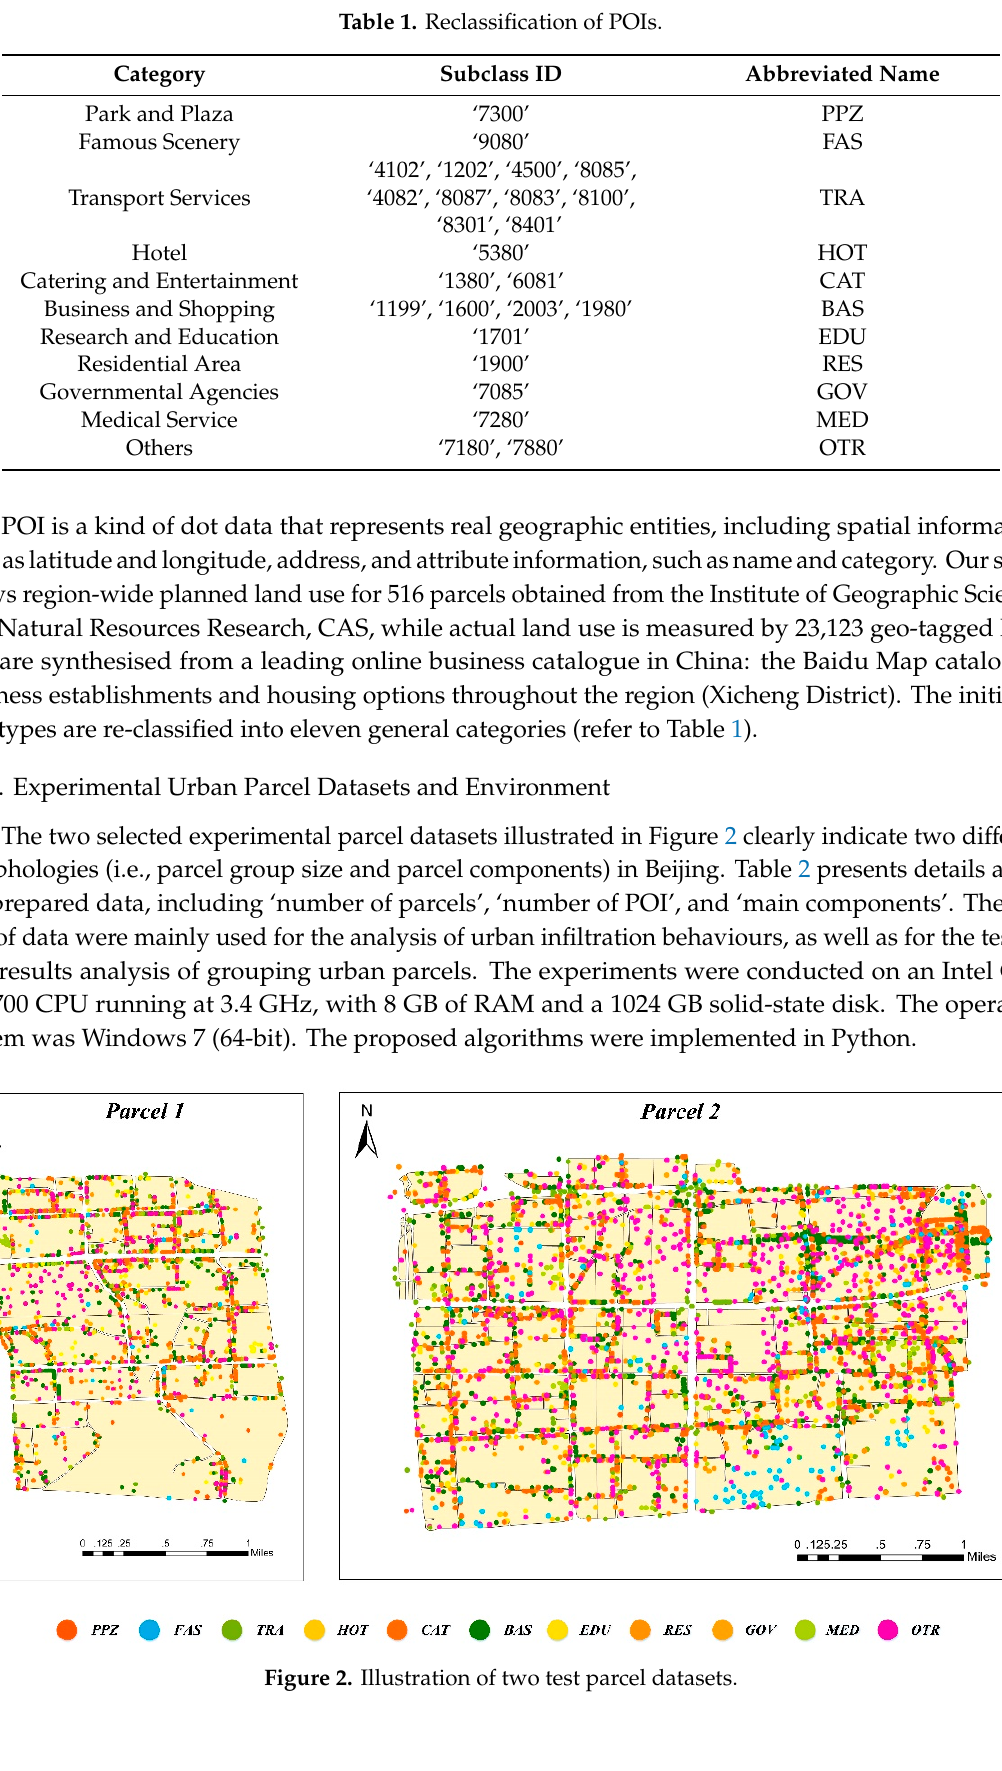
Table 1. Reclassification of POIs.